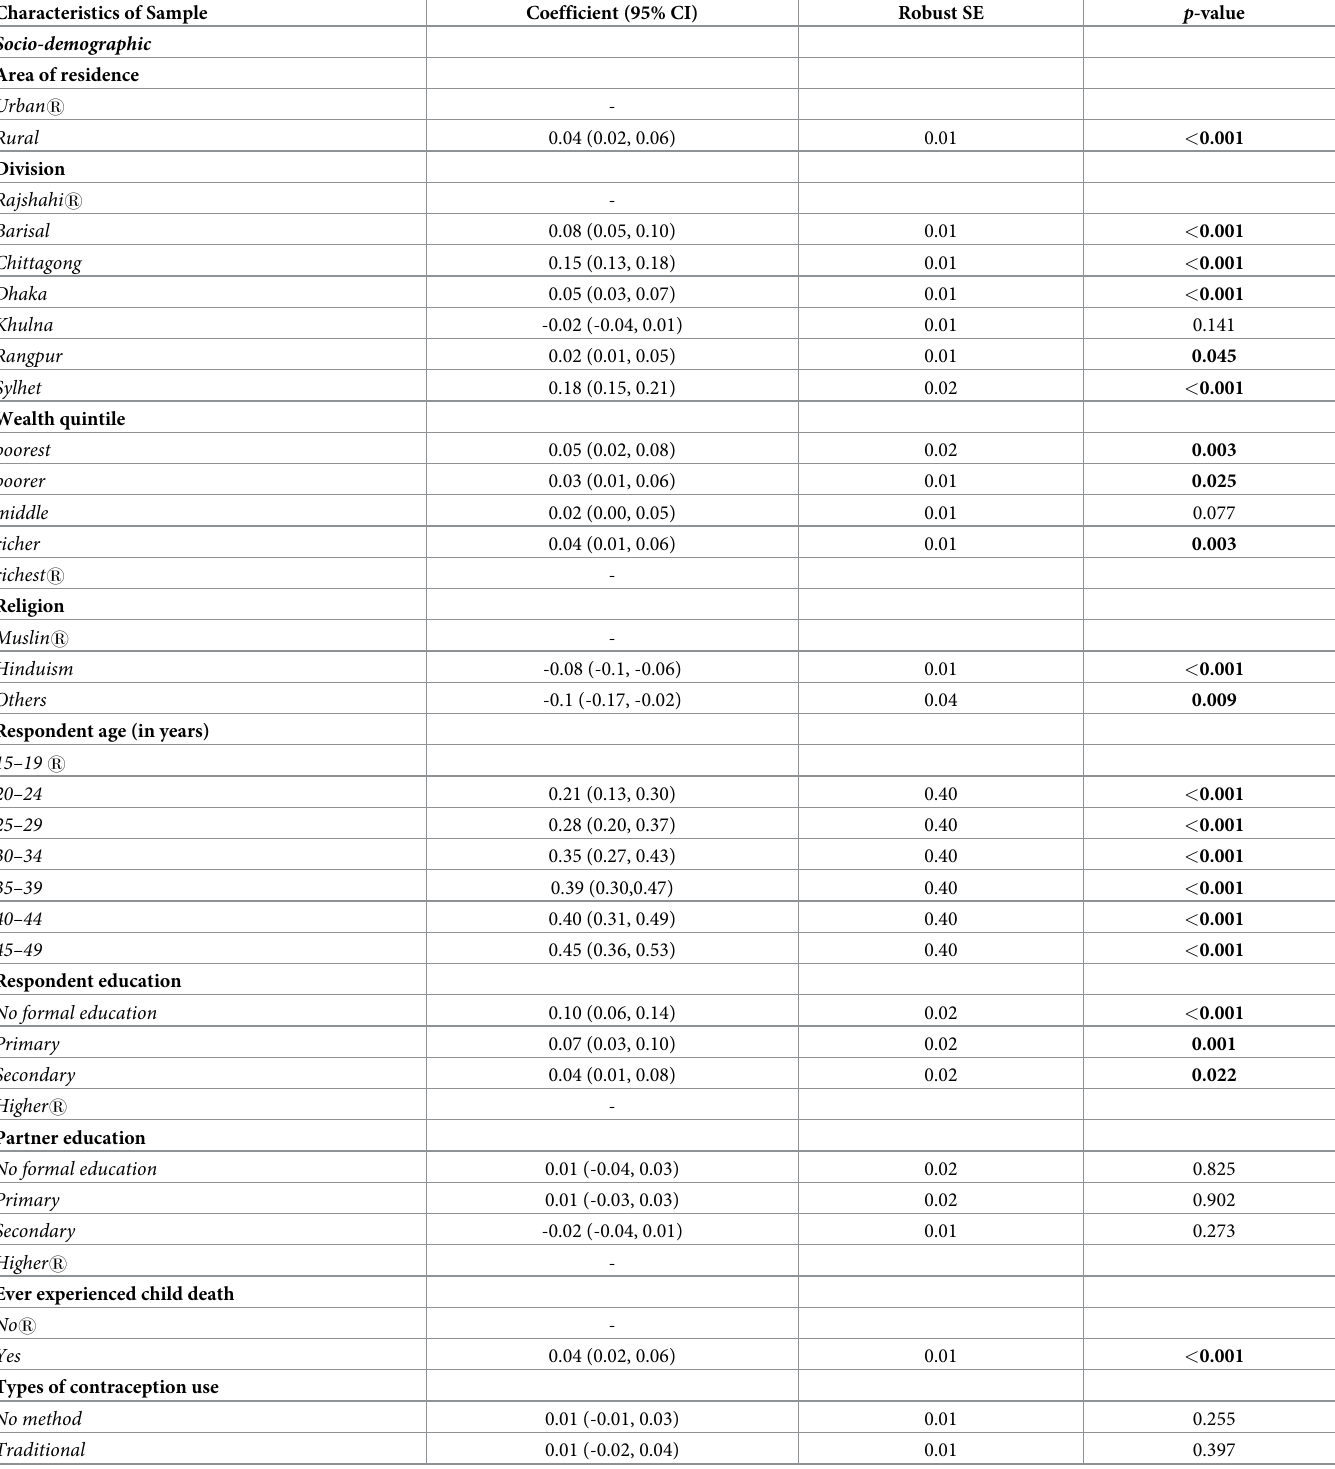
Table 2. Coefficients from the poisson regression analysis examining the perceived ideal number of children by socio-demographic and empowerment characteristics. Characteristics of